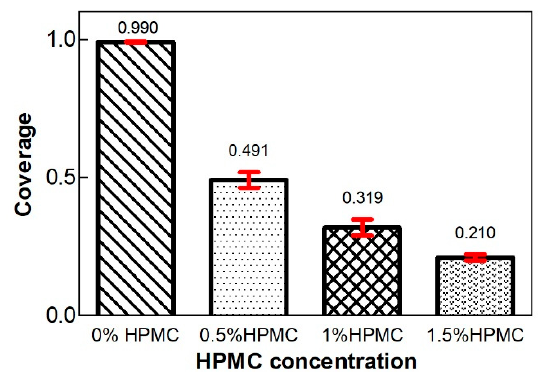
Figure 12. Coverage comparison based on HPMC concentration